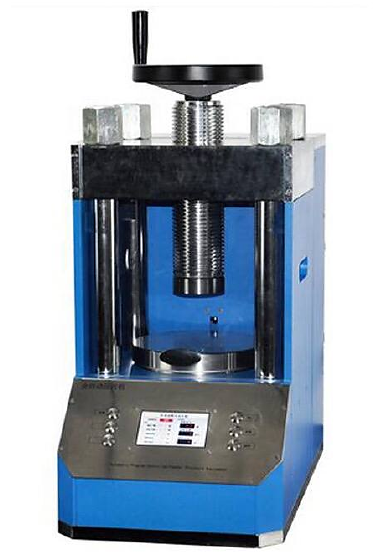
Figure 1: Electro hydraulic compaction